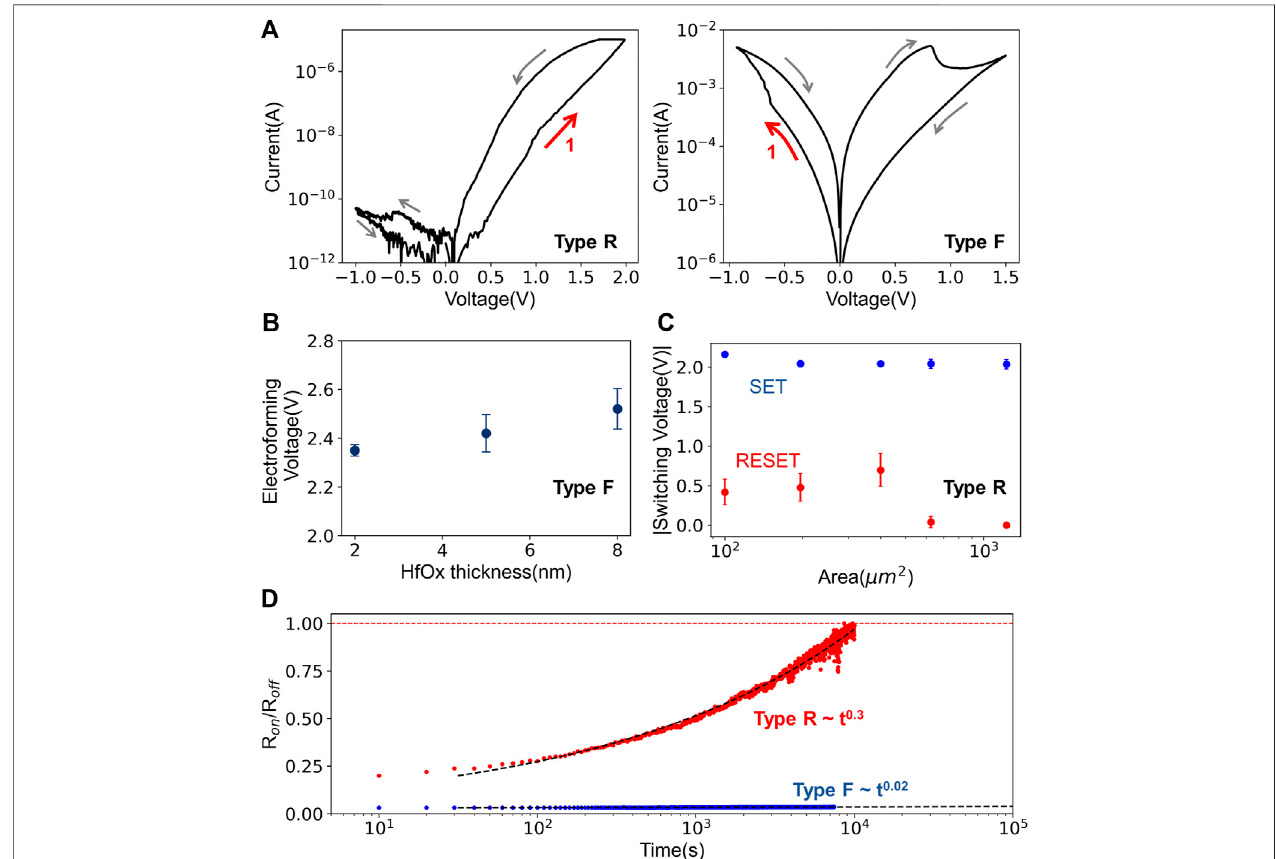
FIGURE 3 | (A) Representative I-V curves of TiN/TiO x /HfO x /Au bi-layer memristive devices for type R (left) , and type F (right) . The arrows point to the resistive switching direction. A clear rectifying behavior was observed in the type R, and a symmetric switching behavior in the type F. (B) Electroforming voltage (median values) asafunctionofHfO x thickness.ElectroformingvoltagesweretailoredbythethicknessoftheHfO x intypeF. (C) SET(blue)andRESET(red)voltages(medianvalues)asa function of device active area size. The smaller the area is, the lower SET/RESET voltage was observed. (D) Retention measurement and fi tting curves. Type F devices (blue) showed an improved retention characteristic compared to type R (red). The fi tted curves are shown with dashed lines, and the fi tting constants were 0.02 and 0.3 for type F and type R, respectively.